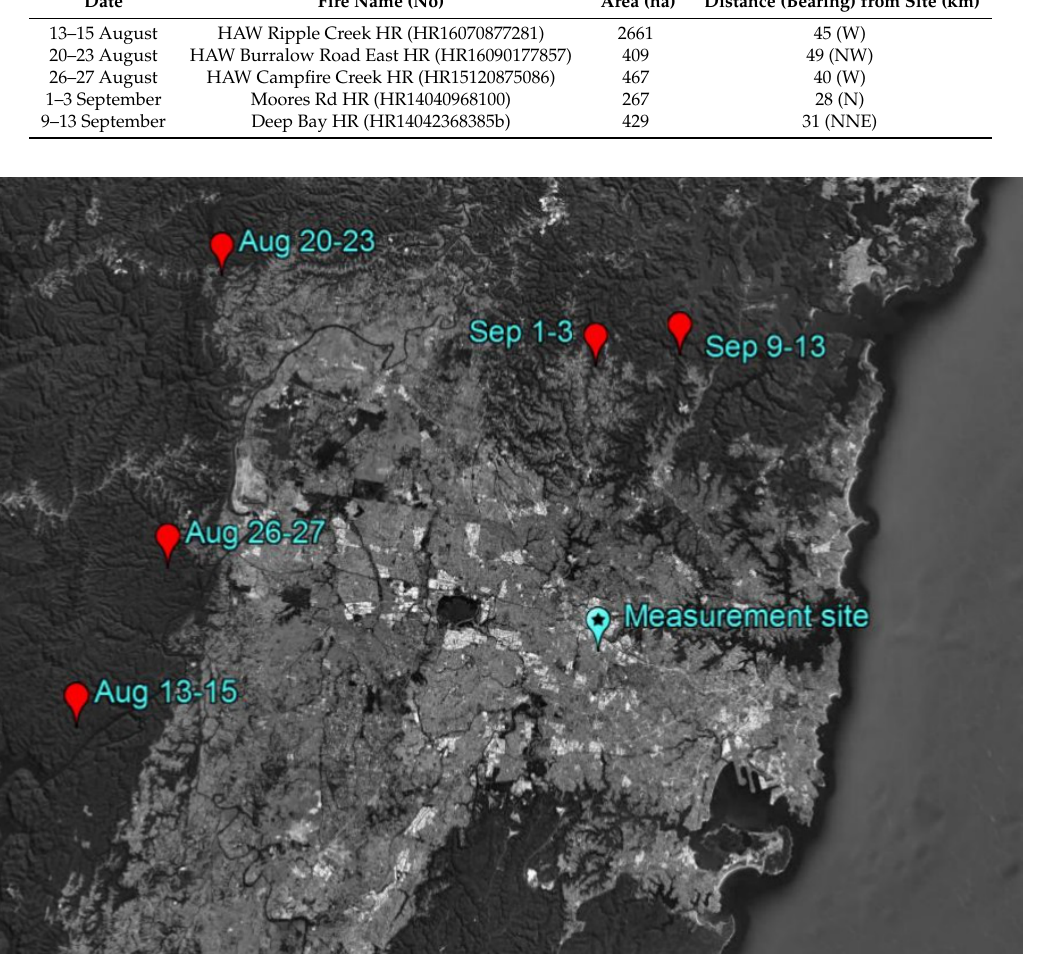
Figure 4. Location of hazard reduction burns and measurement site within the greater Sydney region (source: OEH; MODIS on https://worldview.earthdata.nasa.gov/. Google